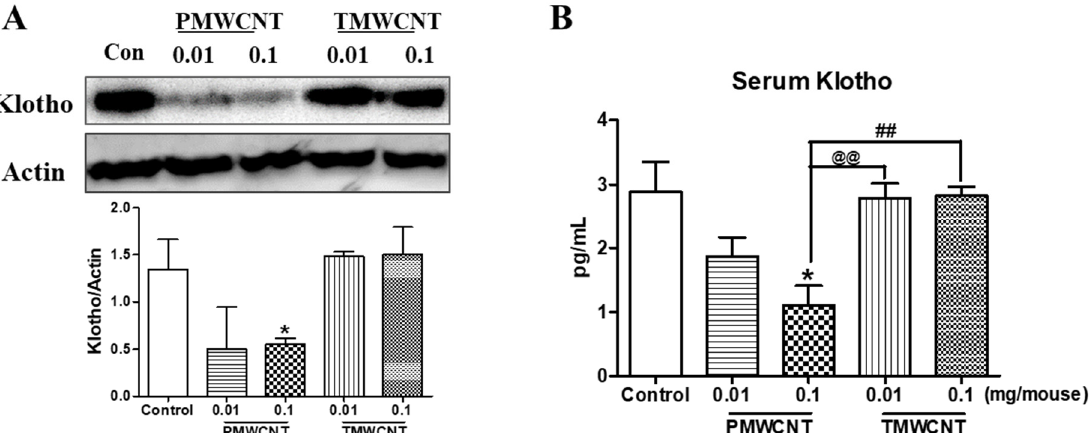
Figure 4. Tissue and serum Klotho level in mice after 6 months instillation. ( A ) Western blot analysis of Klotho in the kidneys of mice after 6 months of treatment with PMWCNTs and TMWCNTs. ( B ) Serum Klotho level of mice exposed to saline, 0.01 mg and 0.1 mg of PMWCNTs and TMWCNTs, respectively. * Statistically different ( p < 0.05) compared to the control group (n = 5). @@ Statistically different ( p < 0.01) between the two indicated groups. ## Statistical difference ( p < 0.01) between the two indicated